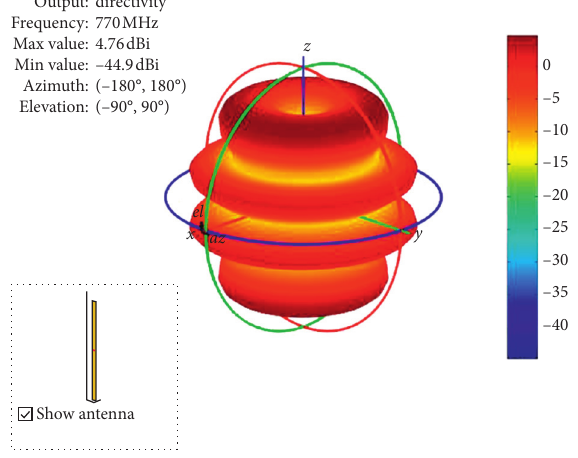
Figure 8: Dipole’s radiation pattern and phase at 770MHz.